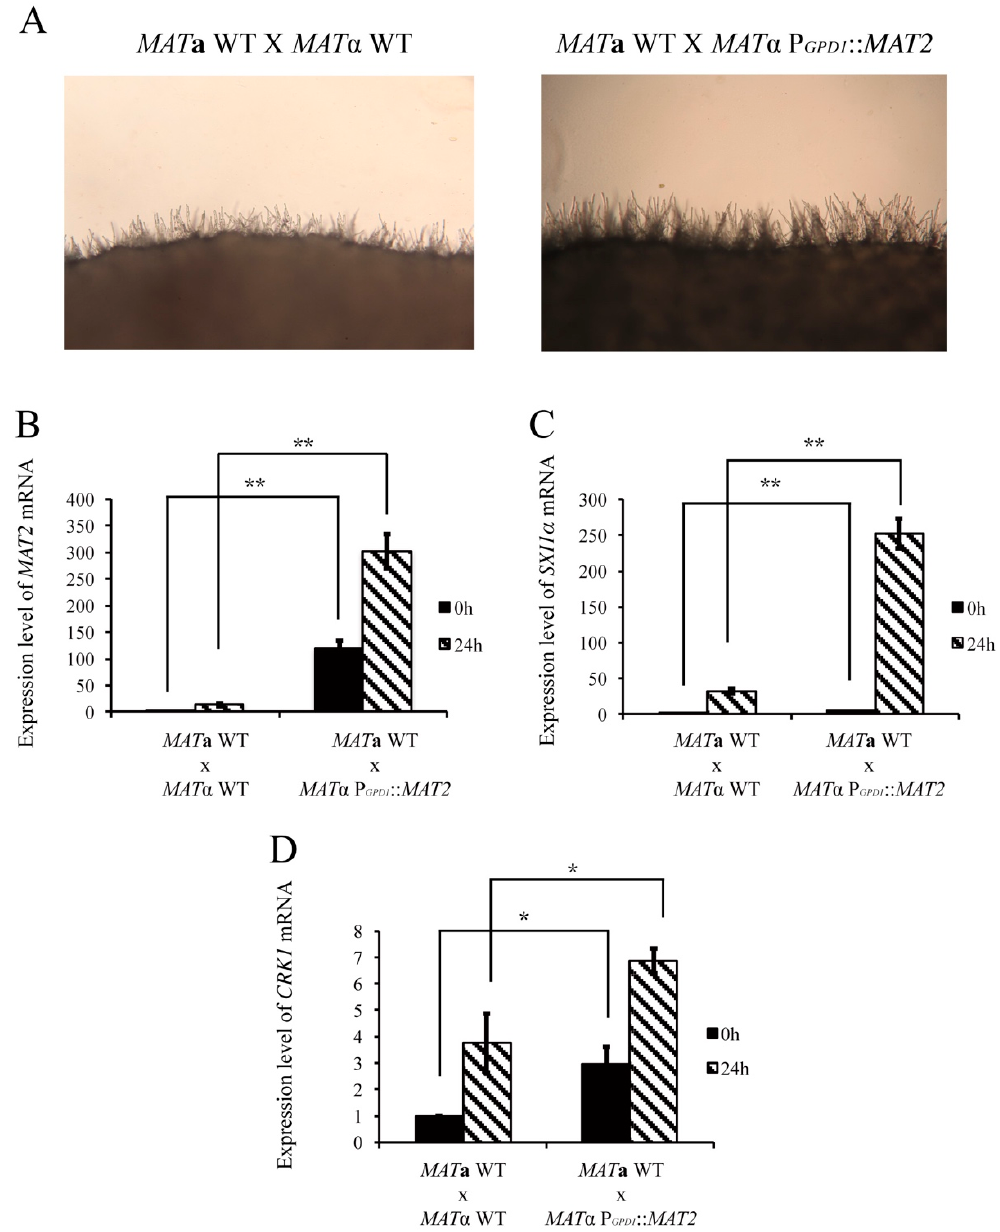
Figure 5. Overexpression of MAT2 increased bisexual filamentation and upregulated CRK1 expression. ( A ) Crosses involved C. neoformans MAT a and MAT α wild-type and MAT a wild-type and MAT α P GPD1 :: MAT2 strains were conducted on V8 agar plates incubated at 26 ° C in the dark. Photos were taken 24 h post-incubation at 100 × magnification. The same crosses were also subjected